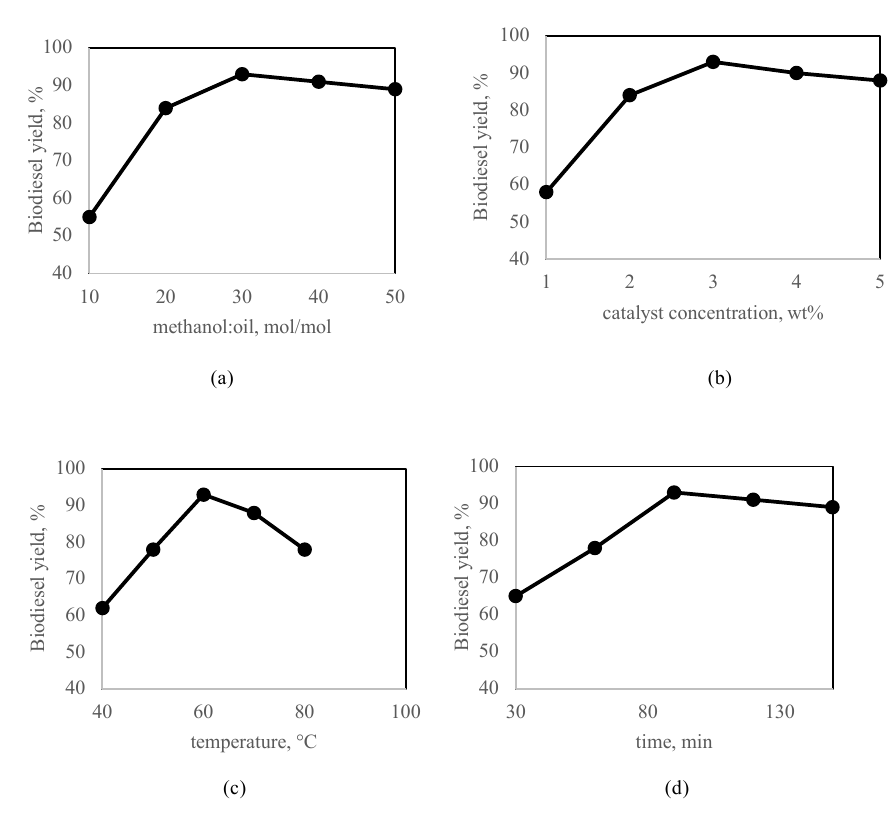
Fig. 7. Effect of: (a) methanol to oil ratio; (b) catalyst concentration; (c) reaction temperature; (d) reaction time on biodiesel